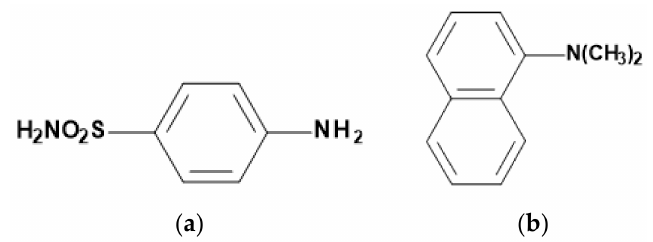
Figure 5. Structural formulas of ( a ) sulfanilamide (SA) and ( b ) N , N -dimethyl-1-naphthylamine